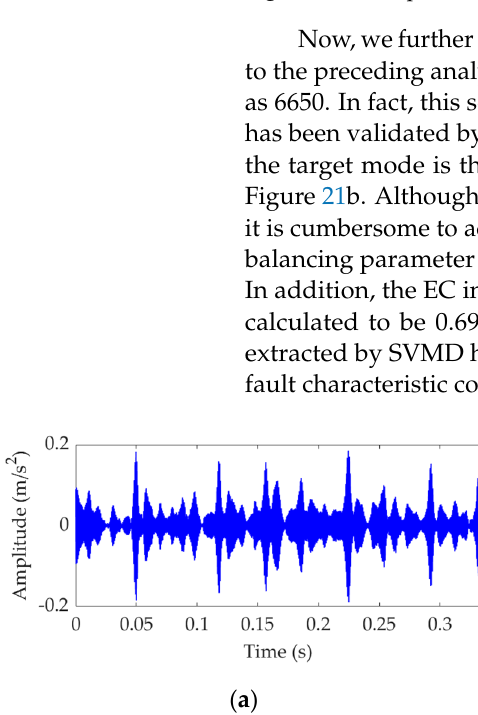
Figure 20. The optimal target mode: ( a ) time − domain waveform and ( b ) SES.